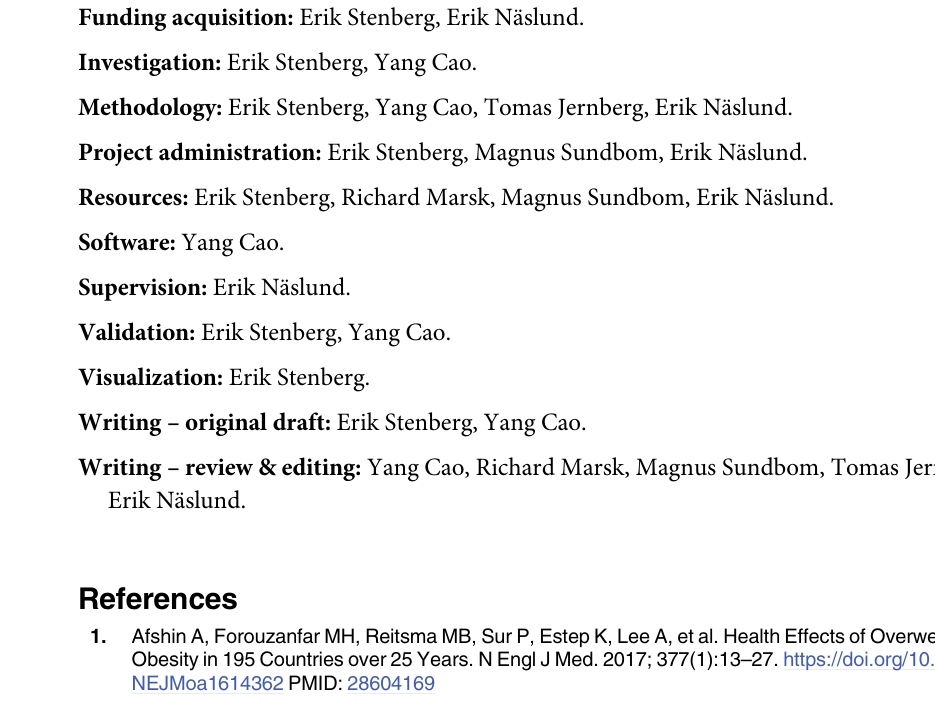
S1 Fig. Cumulative risk for MACEs, stratified by T2DM. For study participants with T2DM, cumulative incidence at 3,000 days was 6.8% for the surgery group and 10.3% for the control group. For study participants without T2DM, cumulative incidence at 3,000 days was 5.0% for the surgery group and 7.0% for the control group. MACE, major adverse cardiovascular event; T2DM, type 2 diabetes. S2 Fig. Cumulative risk for MACEs, stratified by presence of comorbidity other than hypertension. For study participants with comorbidity, cumulative incidence at 3,000 days was 6.7% for the surgery group and 11.2% for the control group. For study participants with- out comorbidity, cumulative incidence at 3,000 days was 3.7% for the surgery group and 5.0% for the control group. MACE, major adverse cardiovascular event. S3 Fig. Cumulative risk for MACEs, stratified by preoperative ACS. For study participants with previous ACS, cumulative incidence at 3,000 days was 18.1% for the surgery group and 18.8% for the control group. For study participants without previous ACS, cumulative inci- dence at 3,000 days was 4.8% for the surgery group and 6.8% for the control group. ACS, acute coronary syndrome; MACE, major adverse cardiovascular